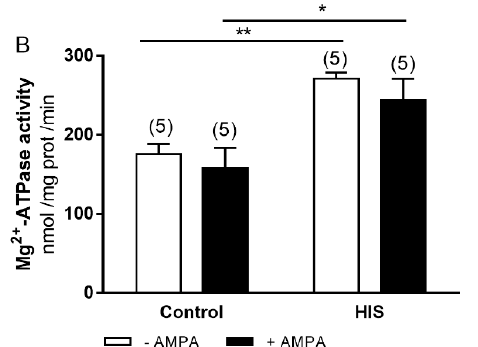
Figure 7. Effects of NMDA ( A ) and AMPA ( B ) receptors activation on Mg 2+ -ATPase activity in neonatal cortex 5 days after HIS (PD 17). The activity of Mg 2+ -ATPase was measured in control rats (PD 17) and after HIS (PD 17), following the protocol described in the Materials and Methods section. To evaluate the influence of NMDA and AMPA receptor activation on Mg 2+ -ATPase activity, the corresponding plasma membranes were preincubated for 6 min at 30 °C with 140 μ M of NMDA and 140 µ M of AMPA, respectively. Each bar represents the mean ± SEM for n = 5 * p < 0.05 and ** p < 0.01 using a two-way ANOVA and Bonferroni’s post hoc test.